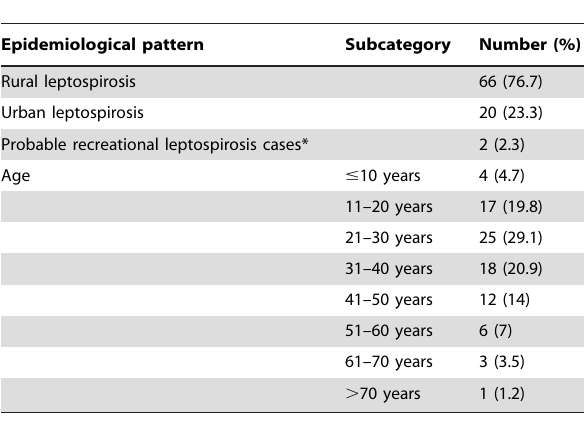
Table 2. Epidemiological pattern and age group of 86 leptospirosis